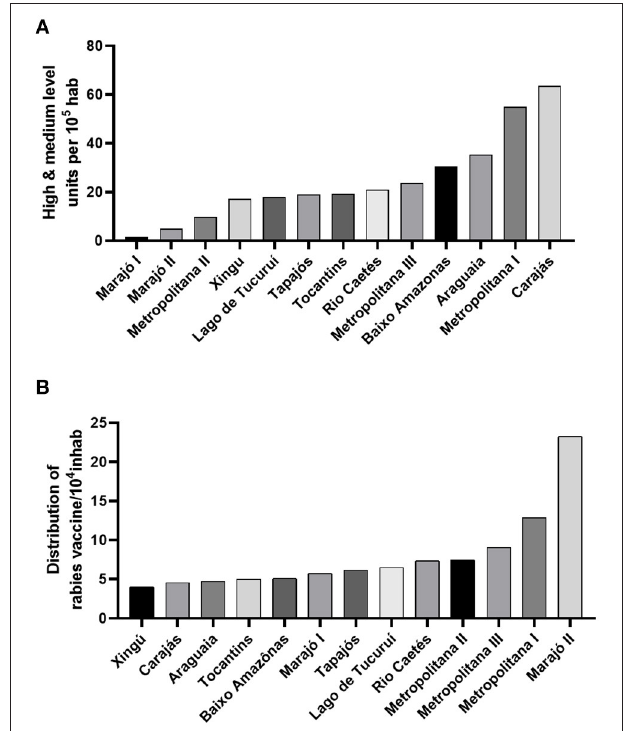
FIGURE 3 | The availability of free medical resources and facilities. (A) human rabies vaccine’s distribution per 10,000 people is heterogeneous and limited in some areas of the state. (B) the coverage of hospitals from medium and high-technological resources is concentrated in a few areas of the territory, and almost absent in neglected